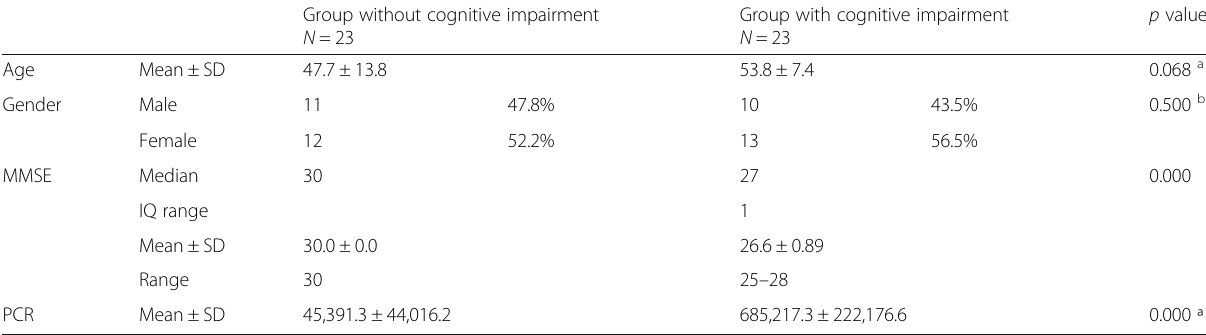
Table 1 Demographic data in both groups